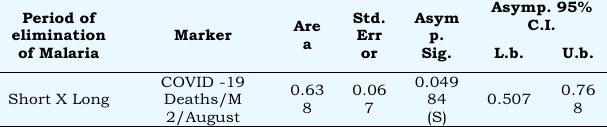
Table 3 ROC – Curve classifying time period groups since malaria elimination date by (COVID -19 Deaths/M) Marker